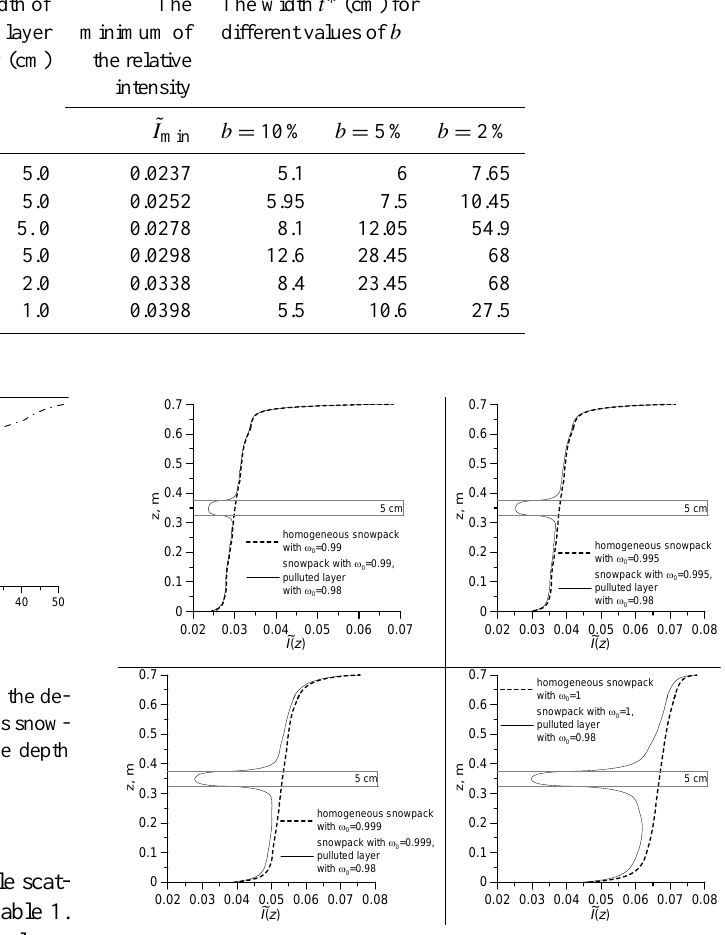
Fig. 15 Fig. 15. Relative intensity ˜ I(z) in the direction (cid:127) ∗∗ on the verti- cal wall AB of the heterogeneous snowpack. Width D = 1m, depth H = 0 . 7m, thickness of the inserted polluted layer t = 5cm, and no black film, for different values of the single scattering albedo ˜ ω snow 0 out of the inserted